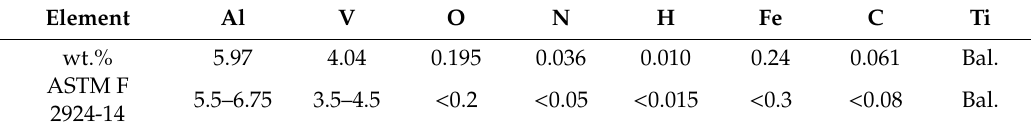
Table 1. Chemical composition and material characteristics of used